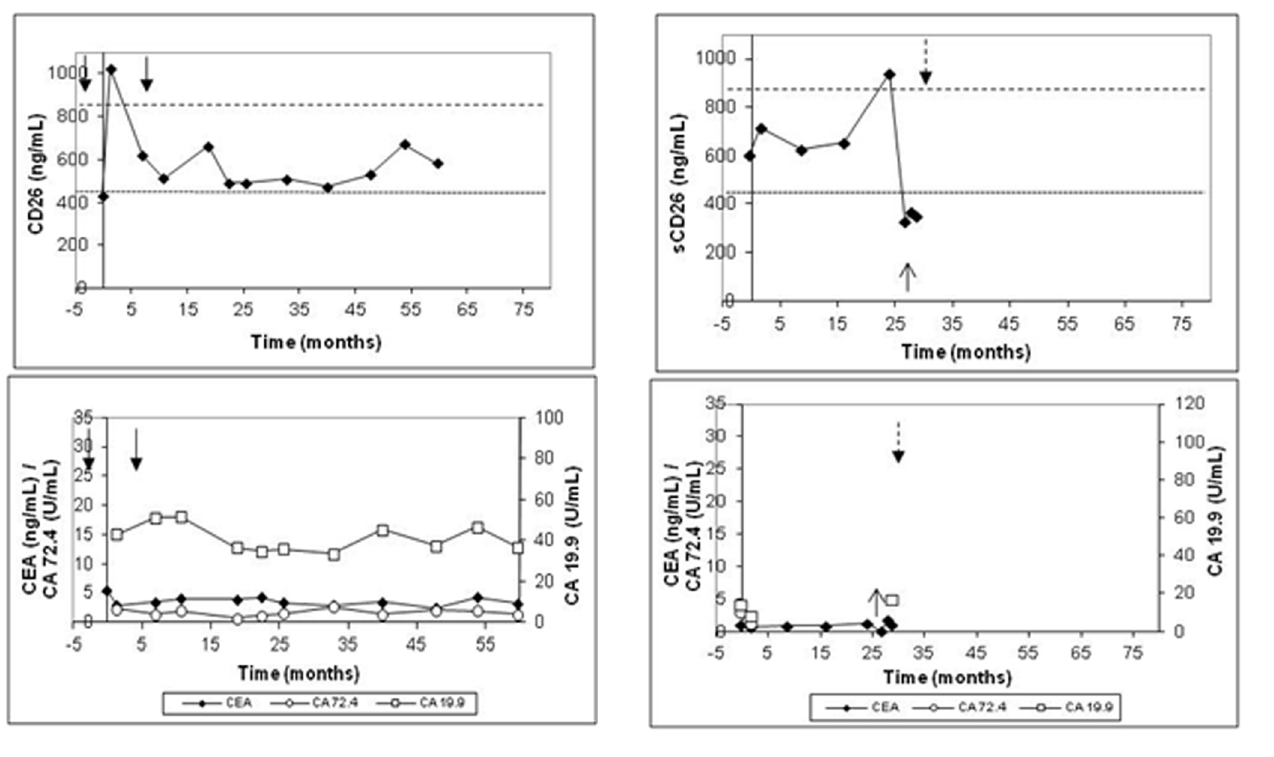
Figure 3. Levels of the sCD26, CEA, CA-19.9 and CA-72.4 in one representative patient with local recurrence (patient 31). The upwards arrow represents the diagnosis of recurrence, and the dashed arrow the time of exitus .